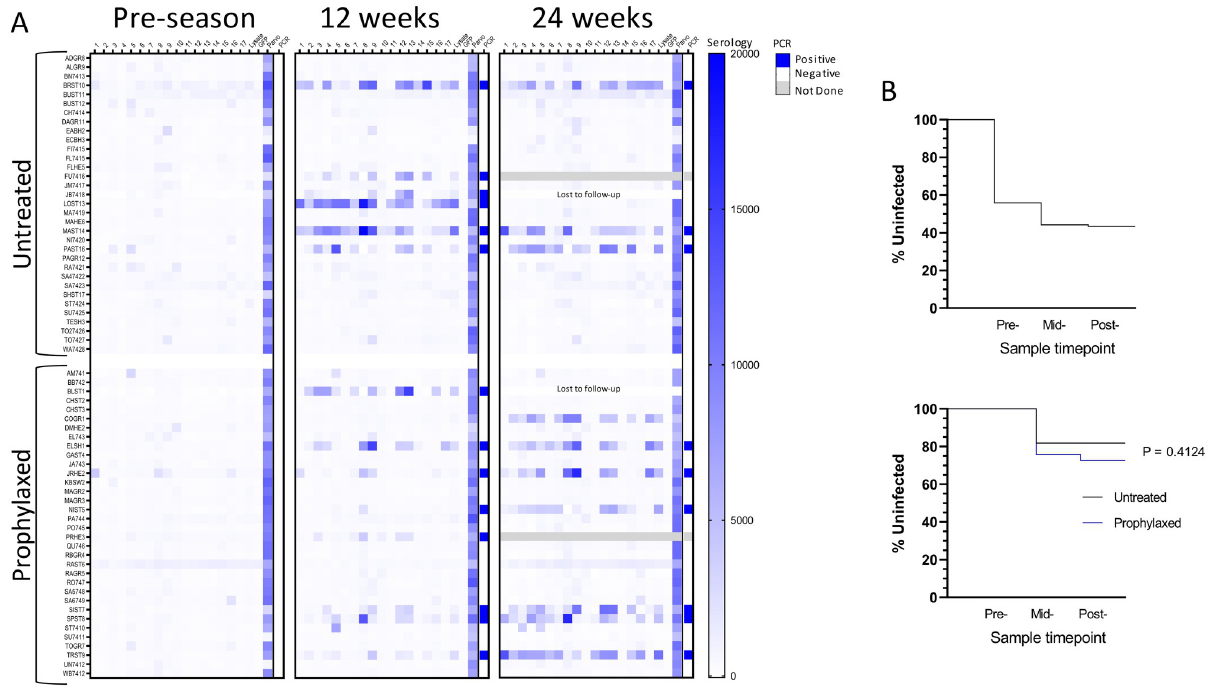
Fig 3. Multiplex serological and blood PCR changes over the transmission season in dogs receiving or not BNZ prophylaxis. (A) Serological and PCR negative dogs (see Fig 2) were randomly assigned to the untreated or BNZ treatment groups and then rescreened at ~12 and ~24 weeks after the beginning of prophylaxis. One dog in each group (gray fill) was moved to BNZ treatment protocol after the 12 week sampling point due to high serum cardiac troponin I (cTnI) levels. One dog in each group was lost to follow-up before the 24 week sampling time due to death or sold by owner. Antigens used in the multiplex assay are as described in Fig 2 and the Materials and Methods. Blood PCR was considered positive if below the cut-off Ct value of 35. (B) Fraction of uninfected dogs in the initial screening group and their decrease in frequency as assessed in (A) at the midpoint (12 weeks) and end of treatment (24 weeks) sample timepoints (top) and comparison of the percentage of uninfected dogs in the untreated and prophylaxed groups over the study period (bottom).